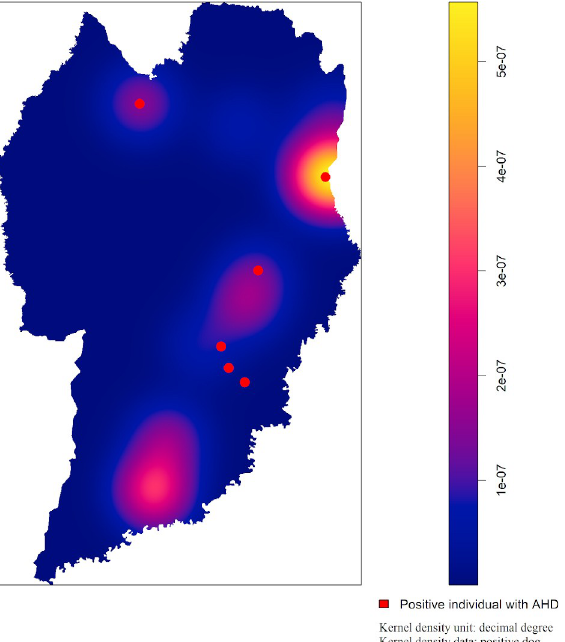
Fig 2. Kernel density analyses of positive dogs to anti- T . gondii antibodies (colored from yellow in hot areas to blue in cold areas) with positive individuals with animal hoarding disorder (AHD) in overlapping points (red) in Curitiba, Parana´, Brazil. The map has been produced by authors, using free open access shapefiles described in methodology section.